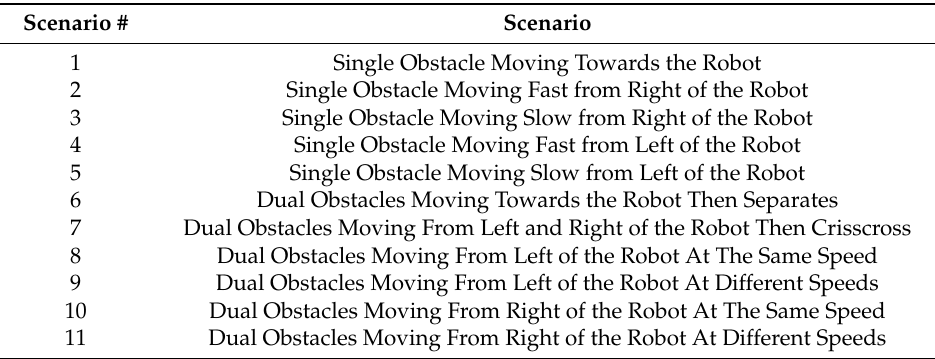
Table 6. Eleven scenarios for dynamic moving obstacles.